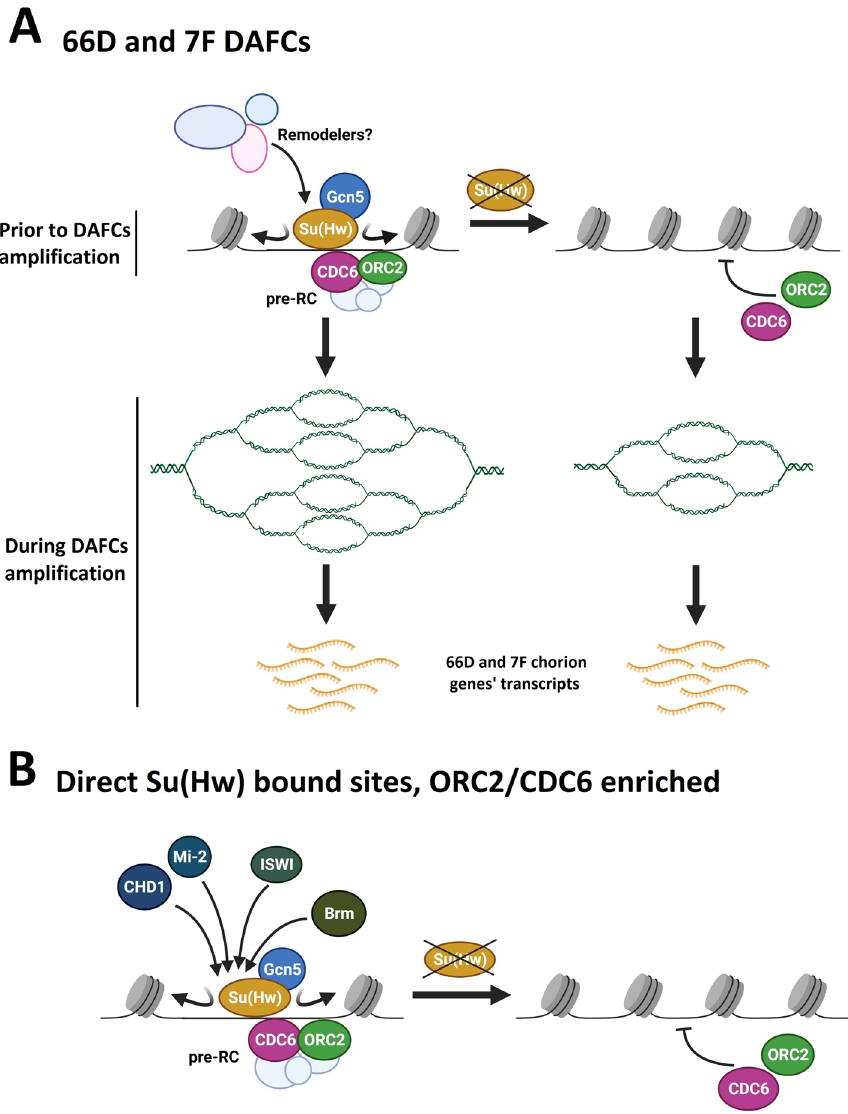
Figure 6. Proposed model describing a role of Su(Hw) in regulation of replication during oogenesis. ( A ) Proposed model describing a role of Su(Hw) in regulation of 66D and 7F DAFCs developmental amplification. Prior DAFCs amplification, Su(Hw) recruits Gcn5 acetyltransferase and organizes the open chromatin structure on amplification regulatory regions of these loci, which promotes the formation of pre-replication complexes (pre-RCs), containing ORC2 and CDC6. Its depletion results in the condensation of chromatin at amplification regulatory regions of 66D and 7F and the disruption of pre-RCs formation. At the late stages of oogenesis, the absence of Su(Hw) in 66D and 7F DAFCs results in the decrease in the amplification of these loci with no change in the transcription levels of the chorion genes located within the 66D and 7F DAFCs. (Image created using BioRender.com). ( B ) Extended model of Su(Hw) functioning at direct Su(Hw) bound sites, ORC2/CDC6 enriched in the genome of Drosophila . Su(Hw) recruits Gcn5 acetyltransferase and Brm, ISWI, Mi-2 and CHD1 remodelers on SBSs and organizes the regions with low nucleosome density. These regions serve as platforms for pre-RCs formation. (Image created using